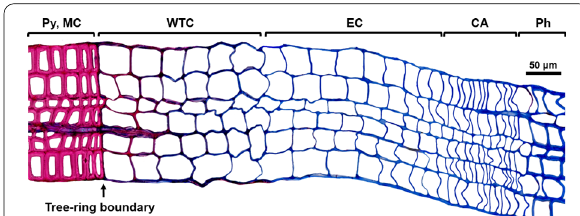
Fig. 4 Development of xylem cells in radial direction. (Py: xylem in the previous year, MC: mature cells, WTC: cells in cell‑wall thickening phase, EC: cells in cell enlargement phase, CA: cambial cells, Ph: phloem)